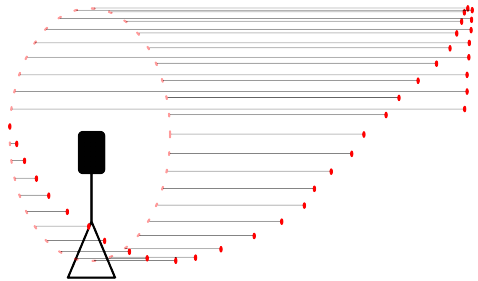
Figure 3. Principe of the point wise (geo-)referencing with the k-TLS based